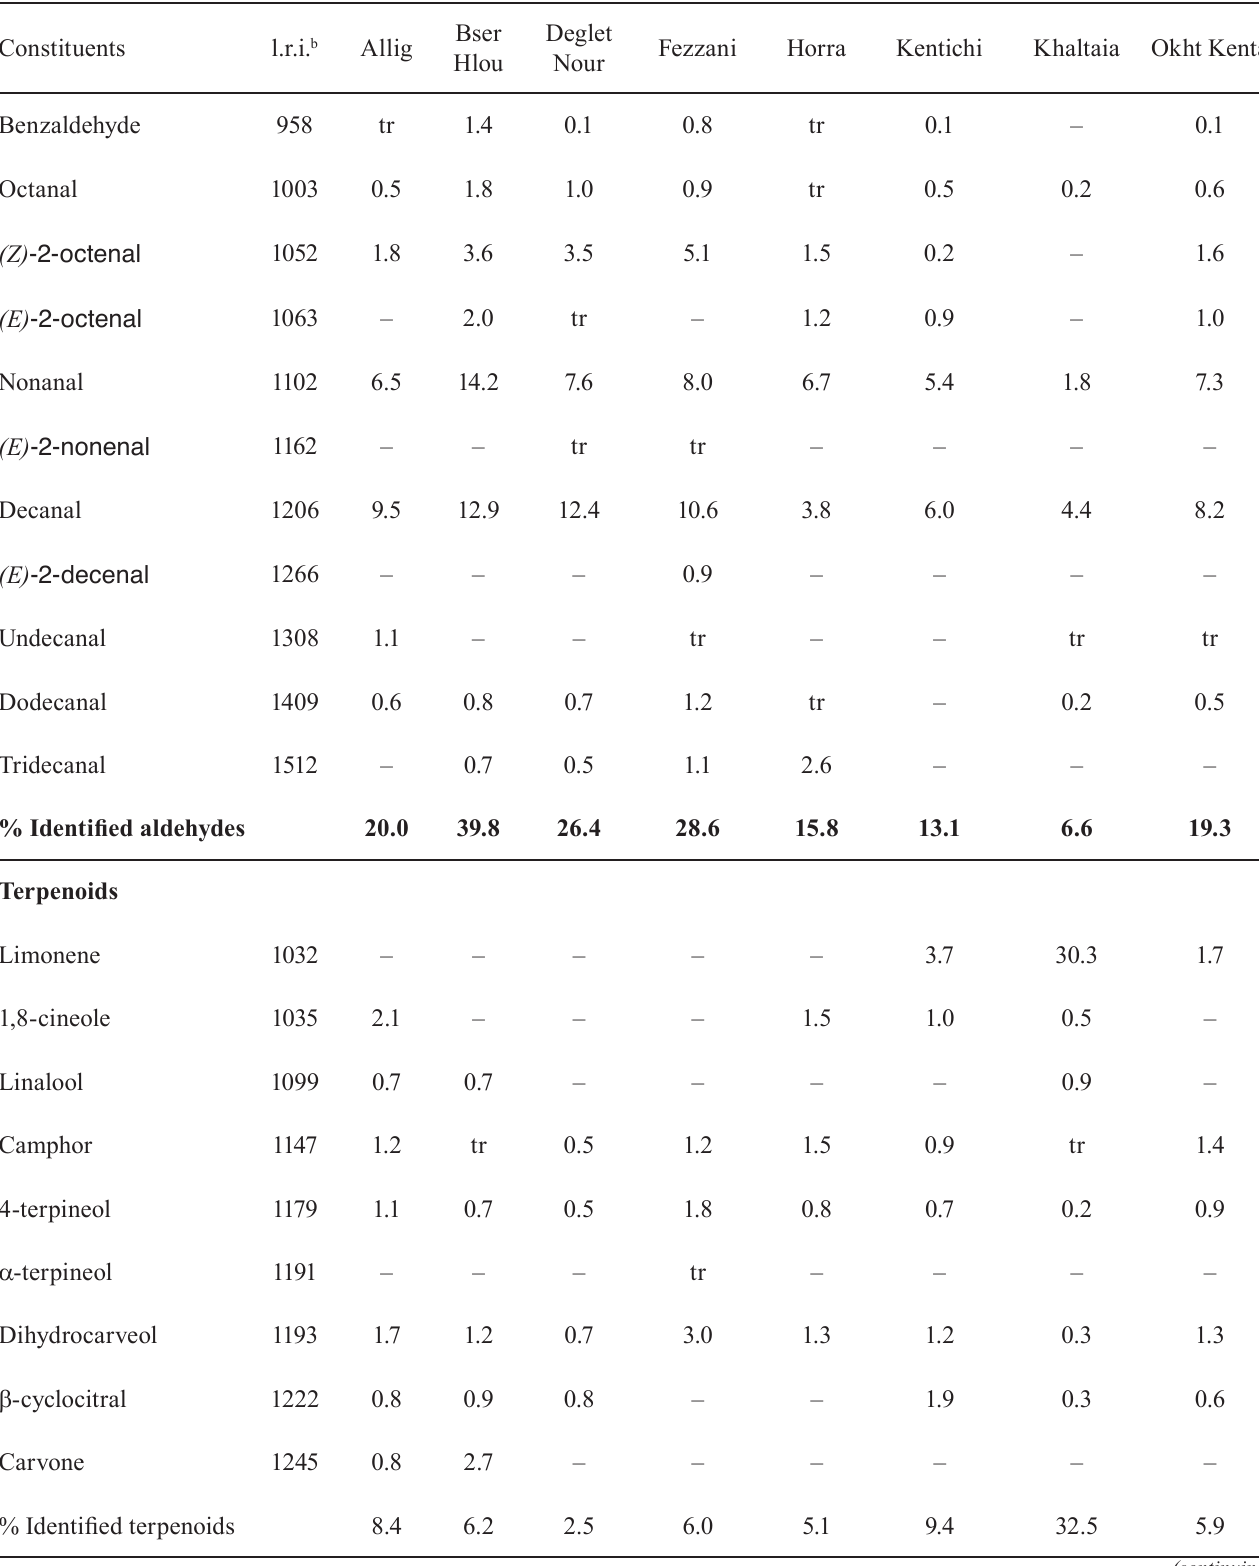
TABLE IV - Volatiles compositiona of date palm fruits obtained from eight varieties at Tamr stage (Cont.)